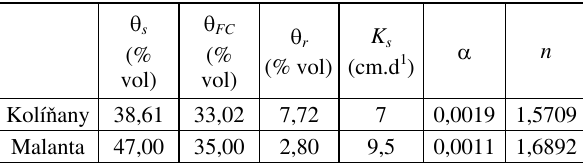
Table 4. Hydrophysical characteristics of soil